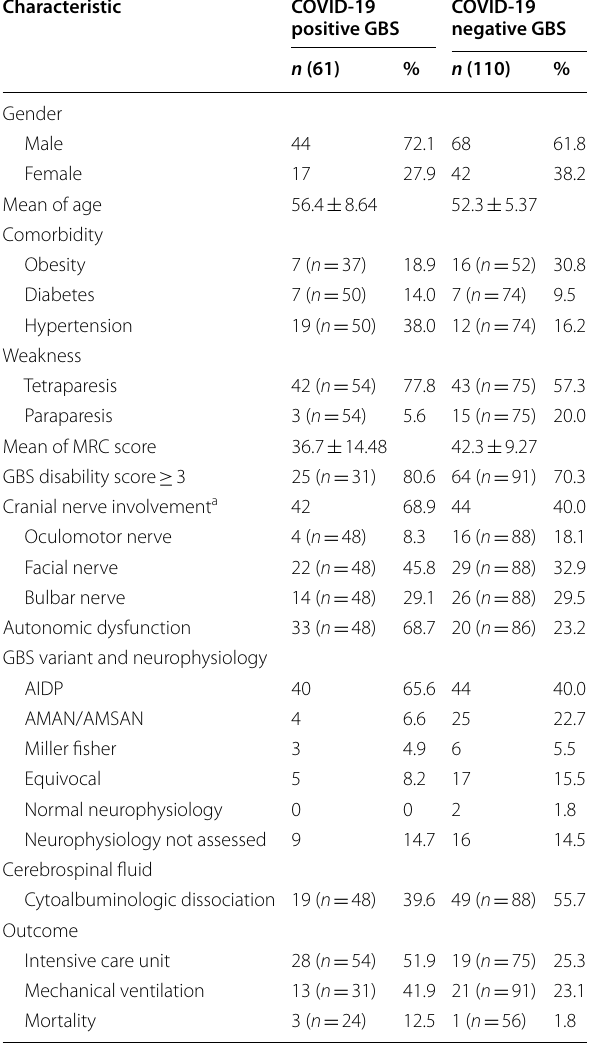
Table 2 Clinical characteristics of COVID-19 positive and COVID- 19 negative GBS patients from four selected